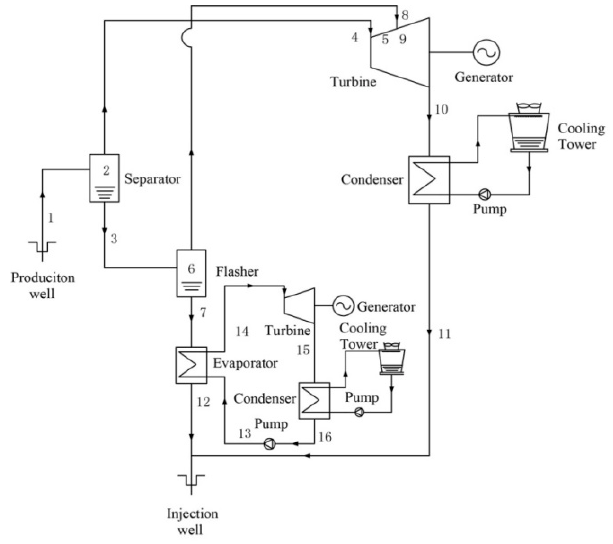
Figure 4. Double ‐ flash ‐ organic Rankine cycle (DFORC) system.